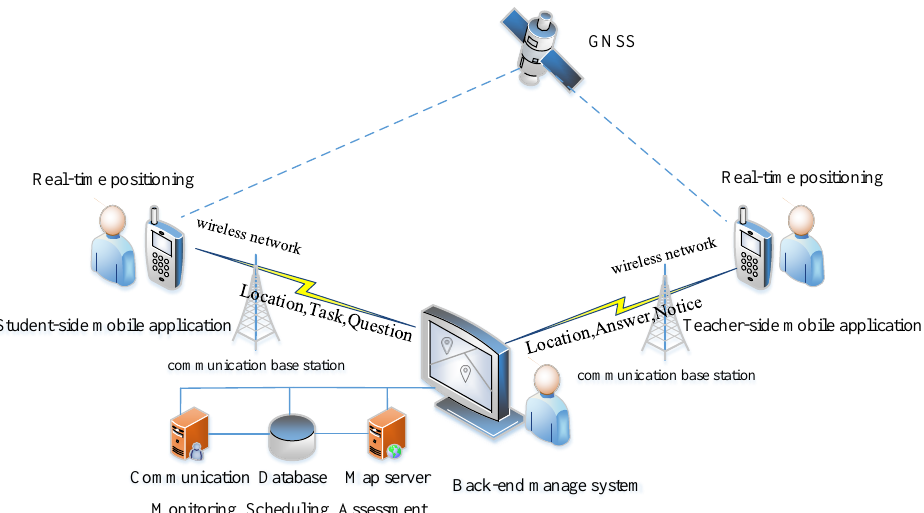
Figure 2. Fieldwork Platform composition.